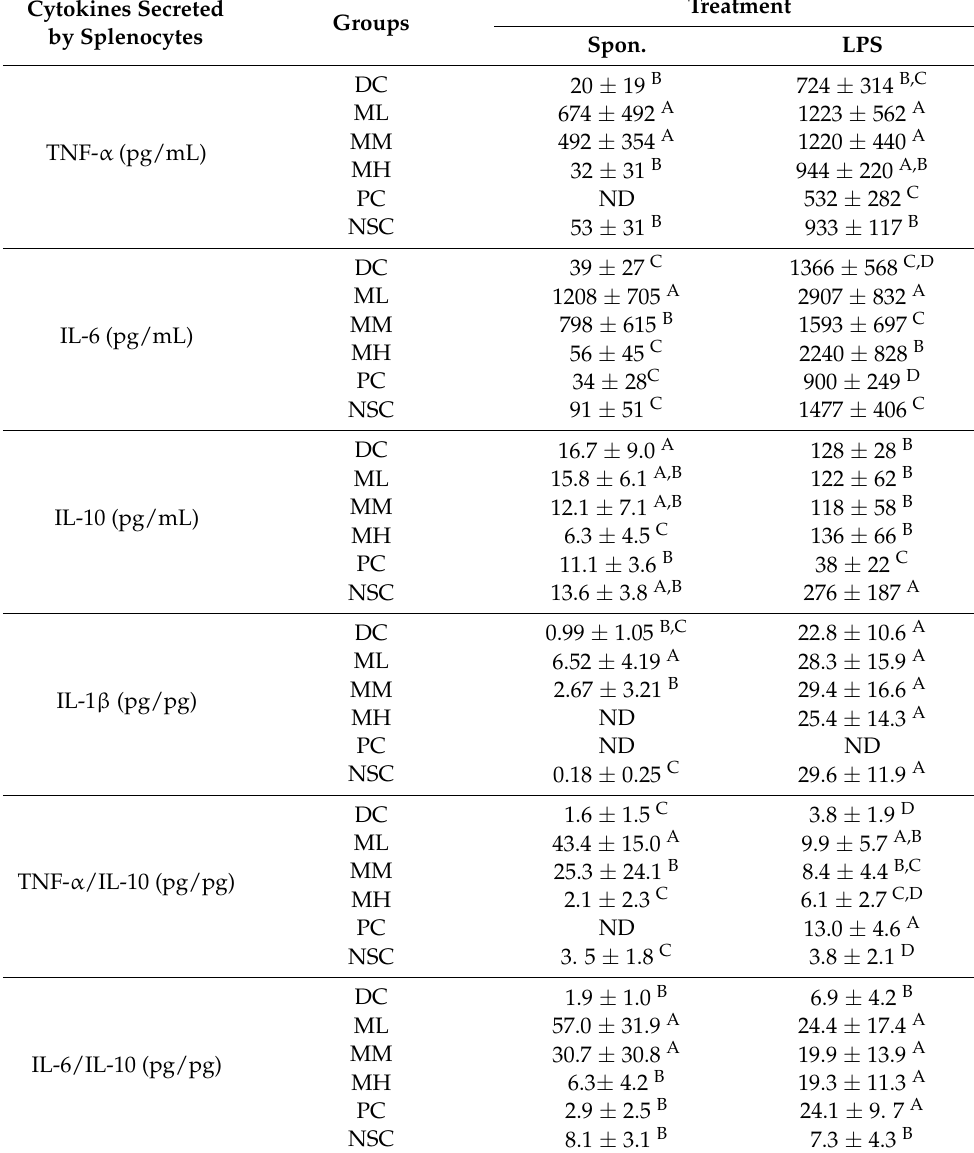
Table 7. Effects of menthone inhalation with different doses on pro- and anti-inflammatory cytokine secretion by peritoneal cells of OVA/Al-sensitized and challenged BALB/c asthmatic mice. Treatment Cytokines Secreted Groups by Splenocytes Spon. LPS DC 20 ± 19 B 724 ± 314 B,C ML MM TNF- α (pg/mL)